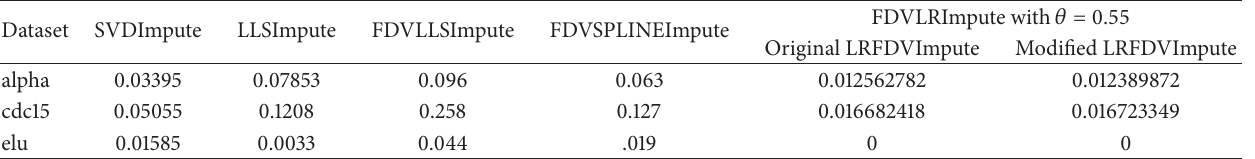
Table 5: Performance comparison with other existing